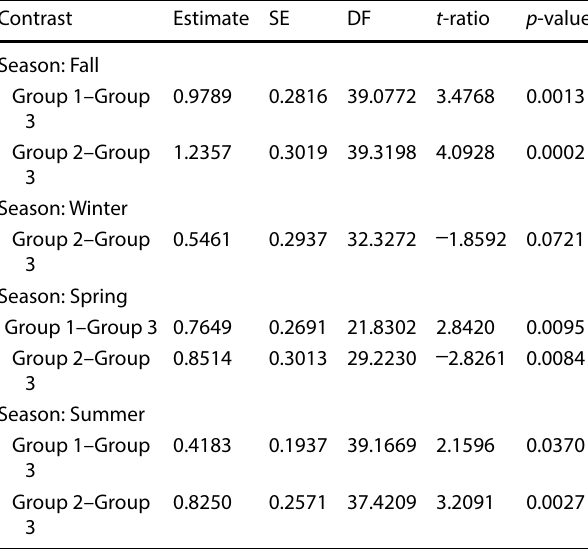
Table 8 Welch two-sample t -tests of groups with unequal sample variances within seasons Contrast Estimate SE